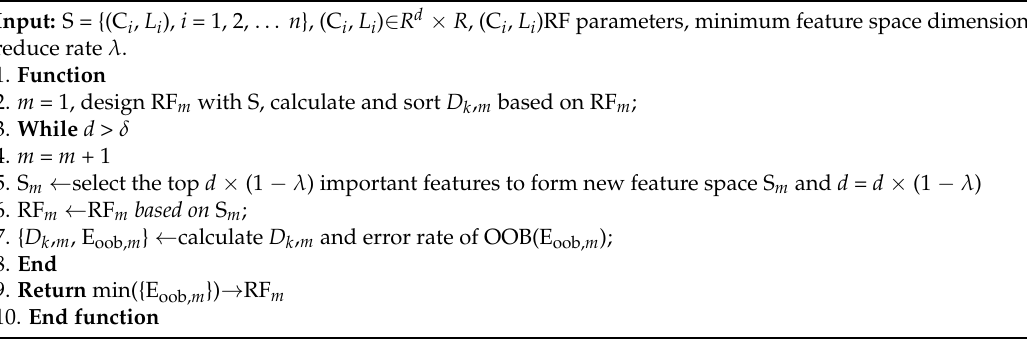
Table 3. Pseudo-code for optimizing feature space.